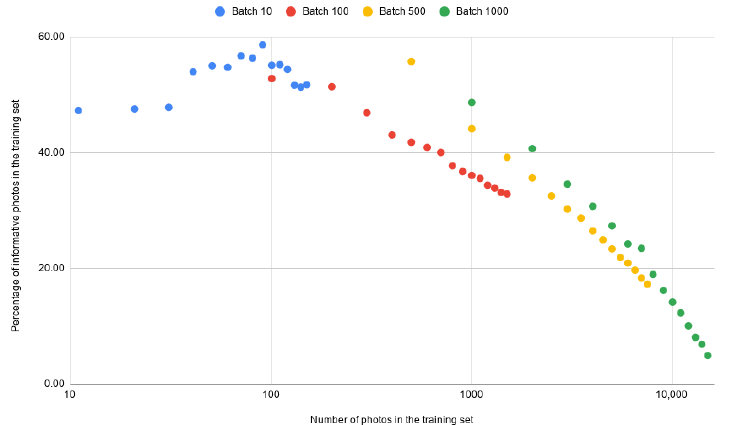
Figure 4. Known to all samples ratio for given batch